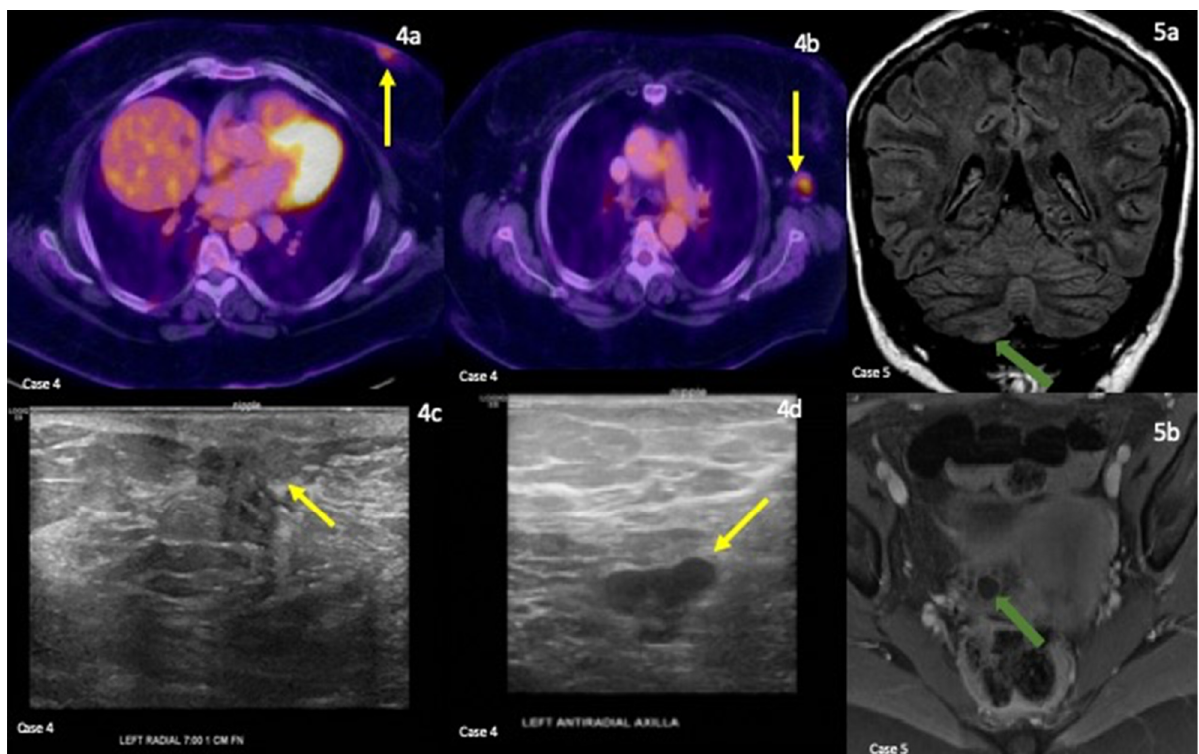
Figure 2. CASE 4: PET/CT of the chest ( 4a , 4b ), breast ( 4c ), and axilla ( 4d ) ultrasonography. Left breast subareolar hypermetabolic mass ( 4a ) with hypermetabolic left axillary lymphadenopathy ( 4b ) corresponding to suspicious left breast mass ( 4c ) and left axillary lymph node ( 4d ) on ultrasound. Coronal FLAIR ( 5a ) sequence. Focal FLAIR hyperintensity in the right inferomedial cerebellum. Pelvic MRI with axial T1 fat suppressed post contrast ( 5b ) sequences. Non-enhancing intrinsically T1 hyperintense right ovarian mass demonstrating fat suppression consistent with a teratoma.